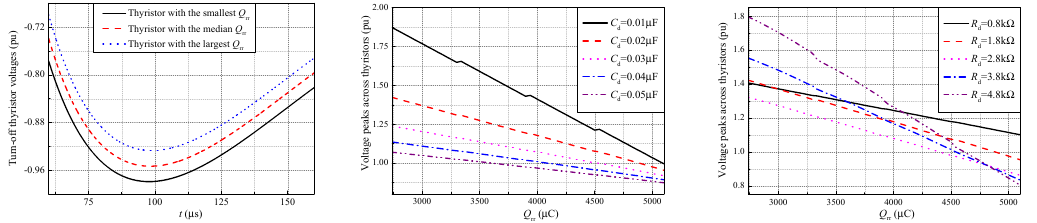
Figure 8. Characteristics of Unbalanced Voltage Distribution of Converter Valve .